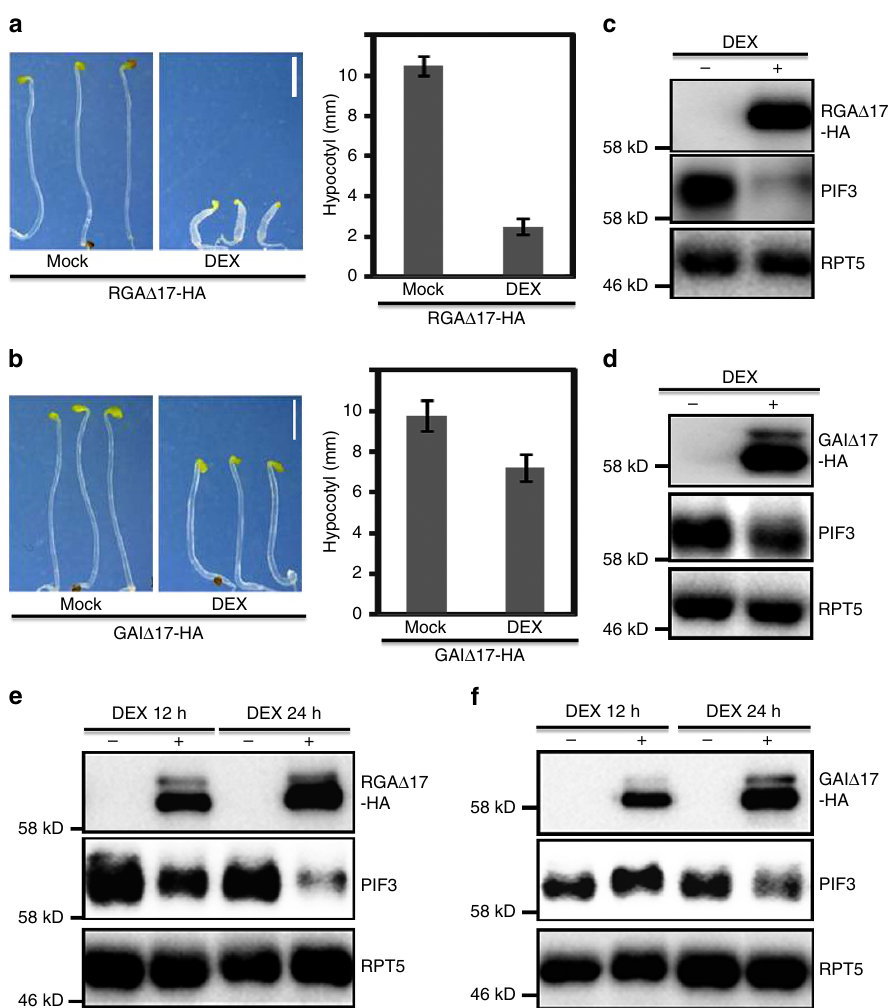
Figure 2 | Induction of DELLAs expression leads to decline of PIF3 protein levels in the dark. ( a , b ) Phenotypes and hypocotyl lengths of 4-day-old RGA D 17-HA and GAI D 17-HA seedlings treated without or with 1 m M DEX in the dark. Means ± s.d. were calculated from at least 30 seedlings. All images were under the same magnification. Scale bar, 2mm. ( c , d ) RGA D 17-HA, GAI D 17-HA and PIF3 protein levels in the plants as shown in ( a ) and ( b ). Total proteins were analyzed by immunoblots using anti-HA, anti-PIF3 and anti-RPT5. ( e , f ) Analysis of PIF3 protein levels after transient induction of RGA D 17-HA or GAI D 17-HA. Four-day-old dark-grown RGA D 17-HA or GAI D 17-HA seedlings were collected and infiltrated without or with 10 m M DEX for 12h or 24h. Total proteins were analyzed by immunoblots using anti-HA, anti-PIF3 and anti-RPT5. Each immunoblot result is the representative of at least three repeats, and RPT5 was used as a loading